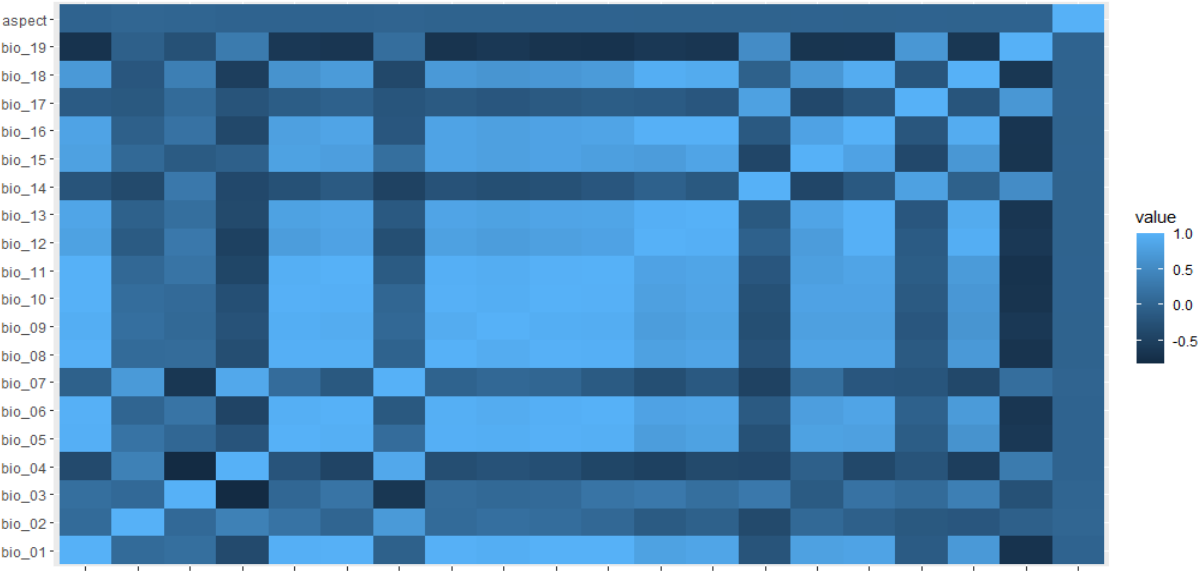
Figure 2. Spearman pairwise correlation coefficients between predictive variables aspect, mean annual temperature (bio_01), mean diurnal range (bio_02), iso-thermality (bio_03), temperature seasonality (bio_04), maximum temperature of the warmest month (bio_05), minimum temperature of coldest month (bio_06), temperature annual range (bio_07), mean temperature of wettest quarter (bio_08), mean temperature of driest quarter (bio_09), mean temperature of the warmest quarter (bio_10), mean temperature of coldest quarter (bio_11), annual precipitation (bio_12), precipitation of wettest month (bio_13), precipitation of driest month (bio_14), precipitation seasonality (bio_15), precipitation of driest quarter (bio_16), precipitation of wettest quarter (bio_17), precipitation of the warmest quarter (bio_18) and precipitation of the coldest quarter (bio_19) considered in the Egyptian vulture nesting habitat distribution model, Nepal. Color variation indicates correlation values.